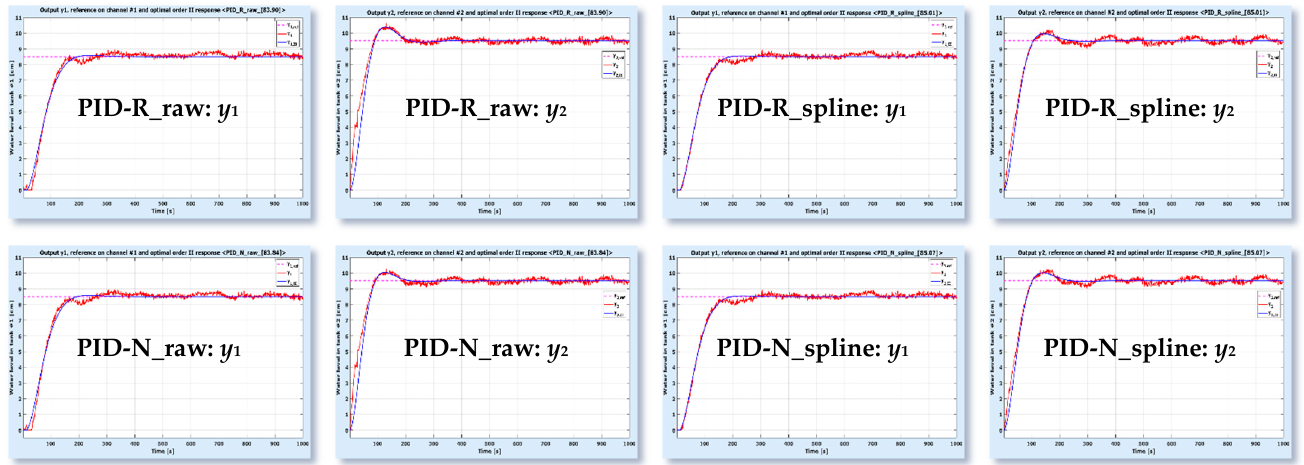
Figure 19. Outputs for the optimal PID controllers and their identified step responses of order II.